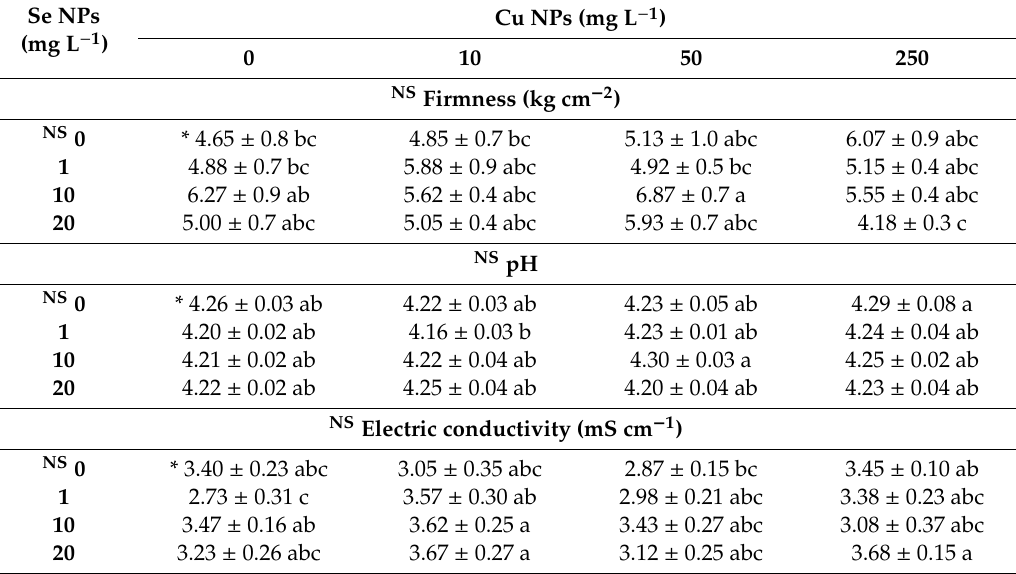
Table 7. Parameters of tomato fruit quality obtained from plants treated with Se and Cu